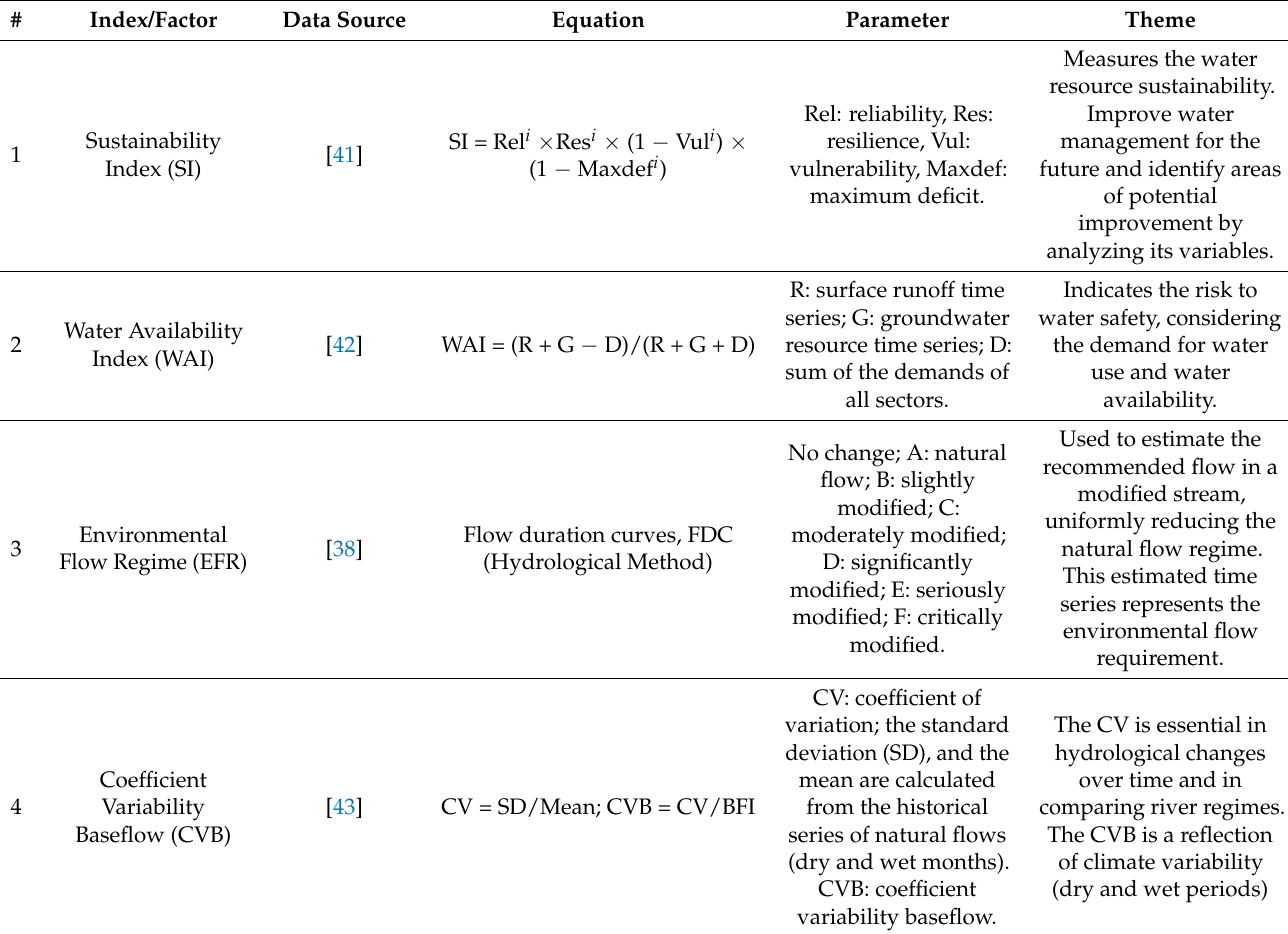
Table 2. Indices used in the WGPI evaluation and its main